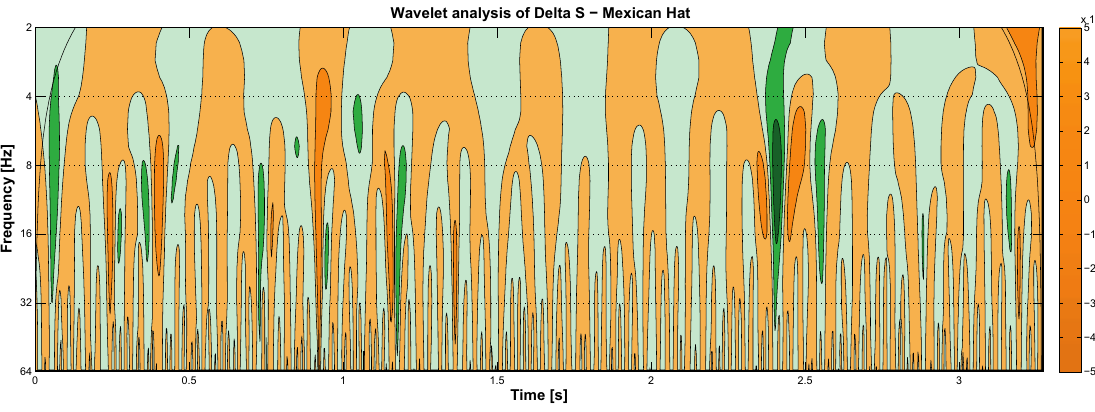
Fig. 9: Wavelet analysis with Mexican hat as a mother wavelet function applied to artificial sweep-ejection time-series in point X / H = 0, Z / H =